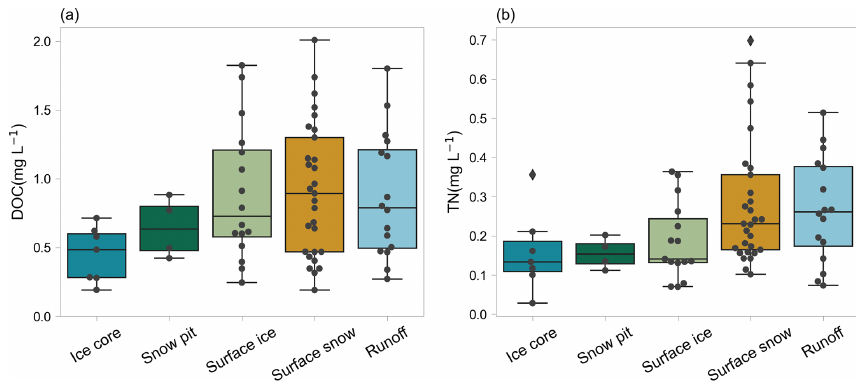
Figure 10. The boxplots of the DOC (a) and TN (b) concentrations in five main glacial habitats on the Tibetan